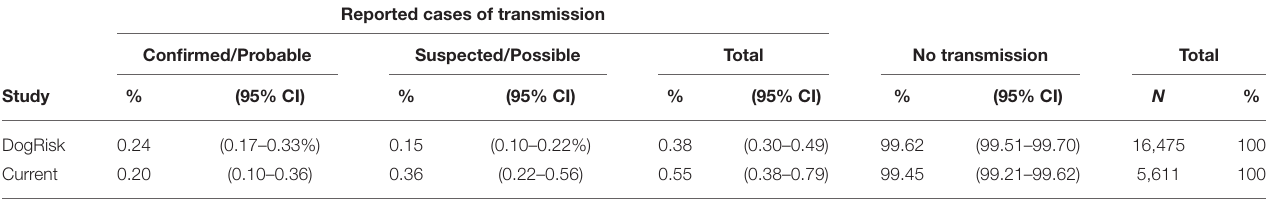
TABLE 6 | Comparison of the current study with the DogRisk study. Reported cases of